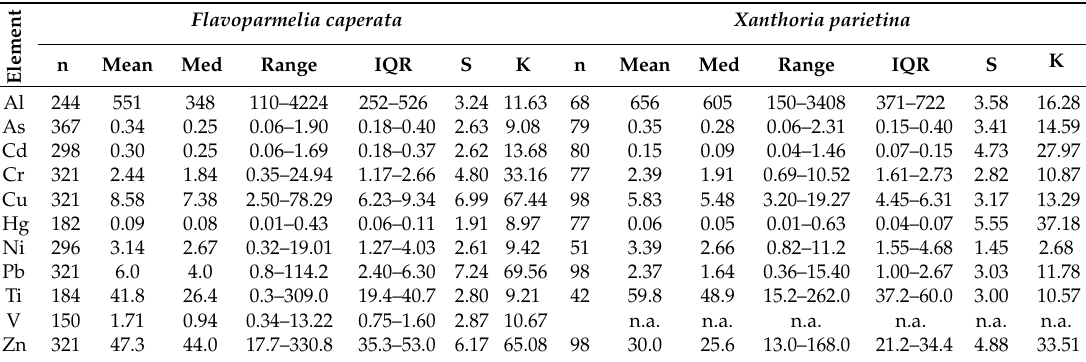
Table 2. Descriptive statistics of element concentration values included in dataset N for the lichen species Flavoparmelia caperata and Xanthoria parietina . Statistics refer to the data counts (n), mean and median values (Mean, Med), minima and maxima (Range), interquartile range (IQR), skewness (S), and kurtosis (K). Mean and median values, minima and maxima, as well as interquartile ranges are expressed in µ g g − 1 dry weight (DW) (n.a., data not